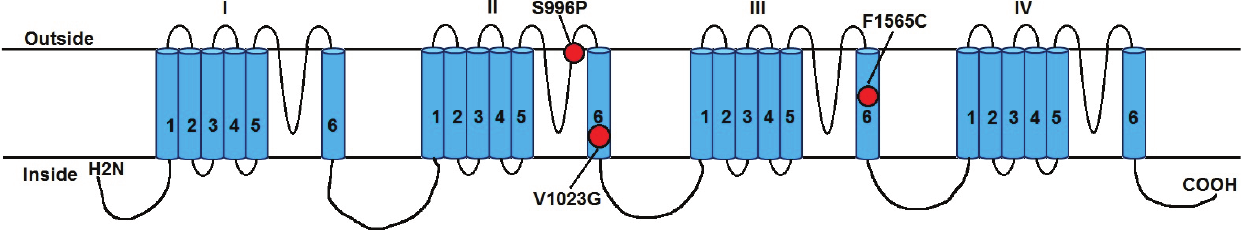
Figure 1. Positions of pyrethroid resistance-associated Vssc mutations of Aedes